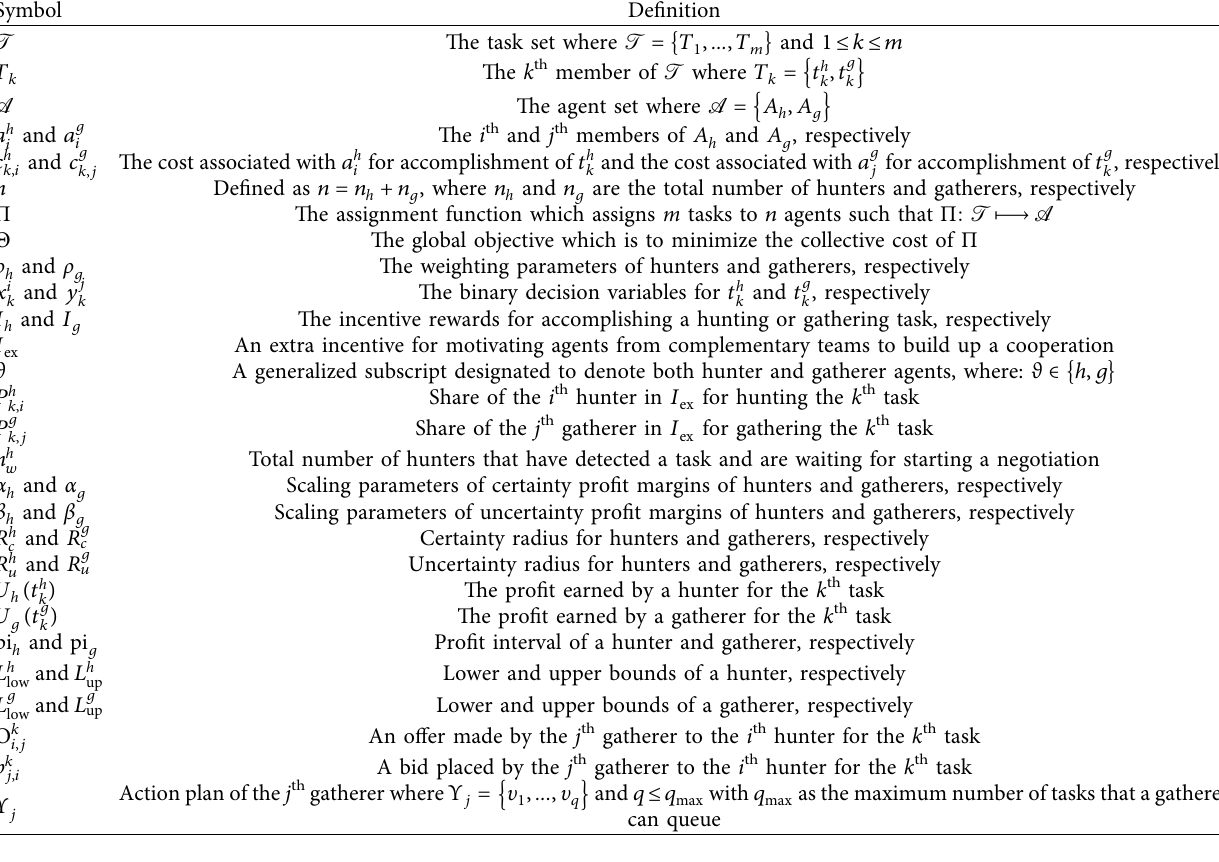
Table 1: Illustration of the notations used globally in this